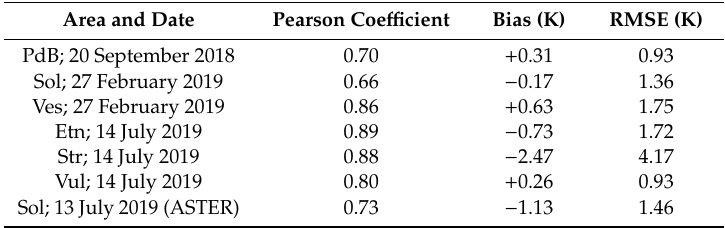
Figure 5. Comparison of LST–ECOSTRESS vs. ASTER. The black line is the bisector. The resulting values of the Pearson coefficient, bias, and RMSE computed for each pair of images are reported in Table 4. Table 4. Results of statistical analysis. RMSE: root mean square error. Positive and negative values of Bias represent ECOSTRESS overestimation and underestimation, respectively.